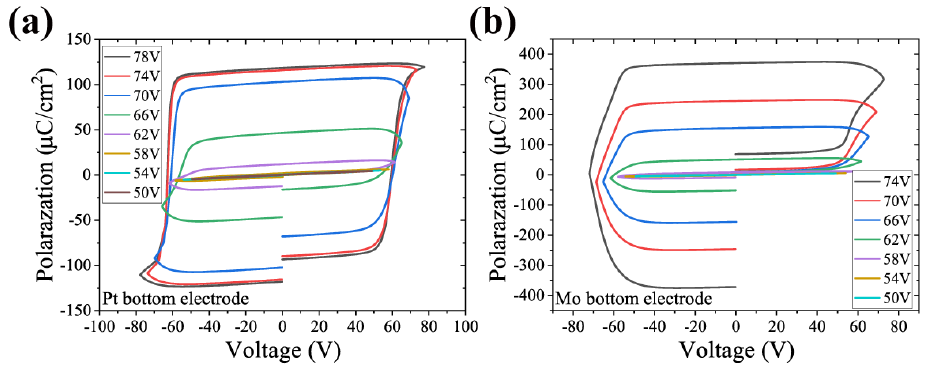
Figure 6. Hysteresis lines of Al 0.7 Sc 0.3 N on two electrodes at different voltages. ( a ) Pt samples, with maximum remanent polarization, were approximately 100 µ C/cm 2 and ( b ) Mo samples were approximately 350 µ C/cm 2 .